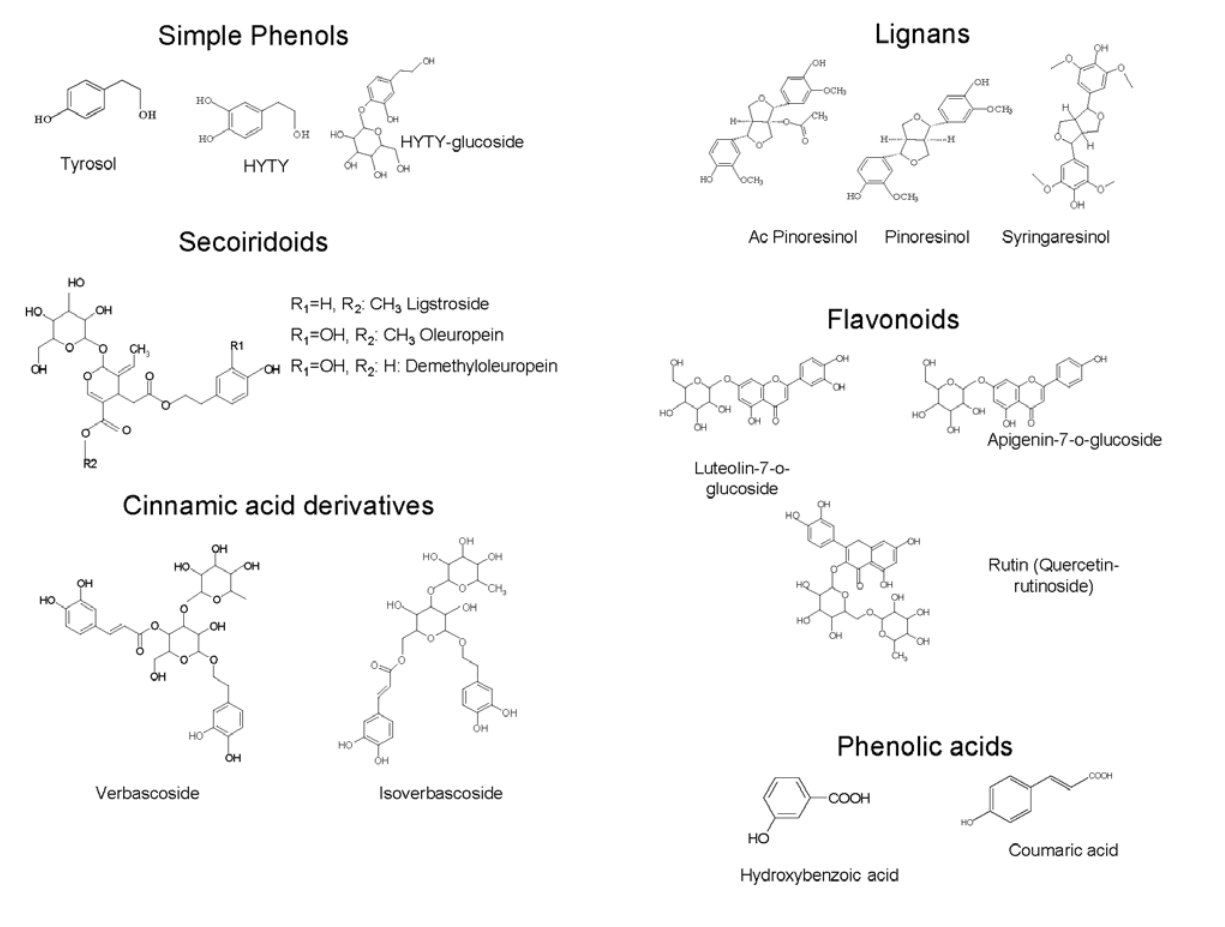
Figure 1. Phenolic classes and structures of main phenolic compounds in olive